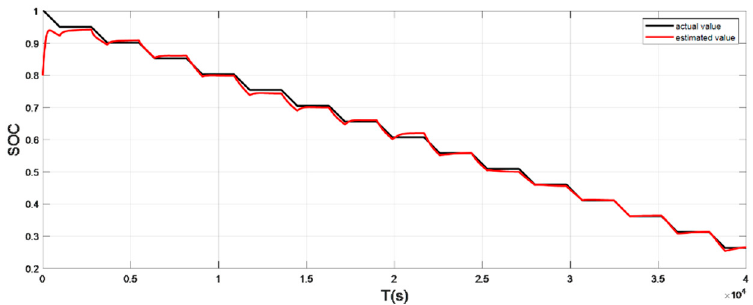
Figure 12. Comparison of the SOC real value and estimated value under constant current discharge (normal temperature: 25 °C).